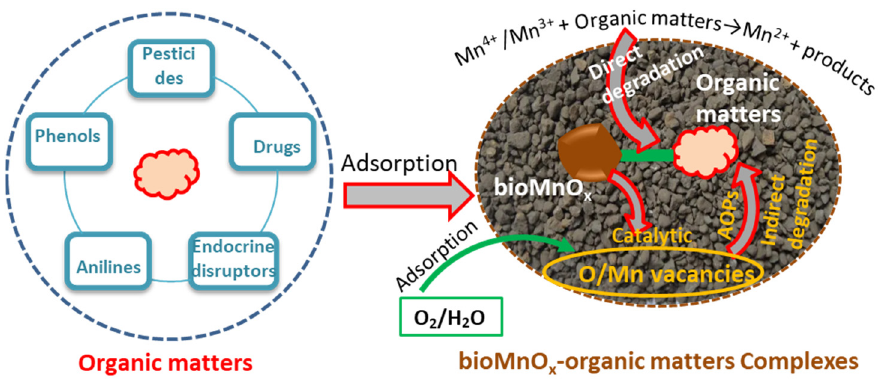
Figure 5. The schematic diagram for the removal of MOCs by bioMnO x .